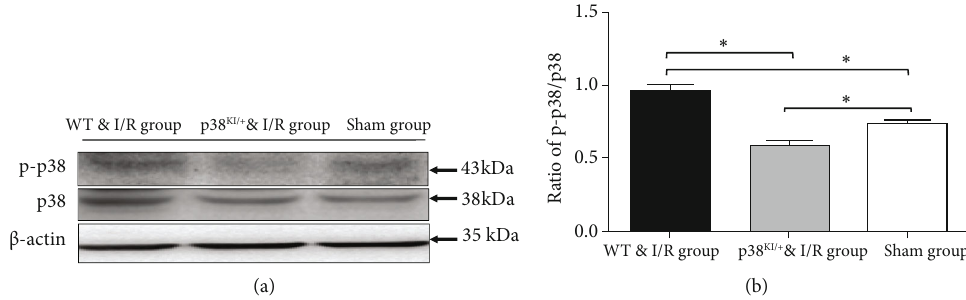
Figure 4: p38 MAPK knockdown reduced p38 MAPK activation in hippocampal CA1 pyramidal cells. (a) Representative images of western blotting in WT and p38 KI/+ mice after BCCAO at 8 weeks of age. (b) Quanti fi cation of p-p38 (p38 MAPK phosphorylation) in WT mice in the sham group, the WT & I/R group, and the p38 KI/+ & I/R group; n = 3 mice per experimental group; ∗ p < 0 : 05 , sham group vs. I/R group; ∗ p < 0 : 05 , p38 KI/+ & I/R group vs. I/R group. ∗ p < 0 : 05 by one-way ANOVA.